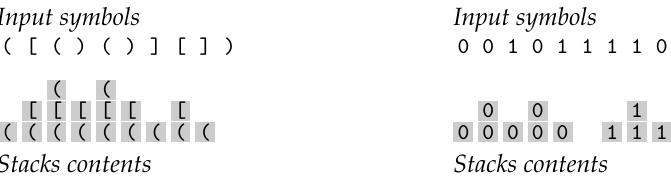
Figure 3. The parse tree corresponding to the propositional formula ( p assignment β ( p ) = 0 and β ( q ) = 1. Note that this tree as well as a tree decomposition for it can be computed easily from the formula (“easily” meaning “in TC 0 ” to be precise).